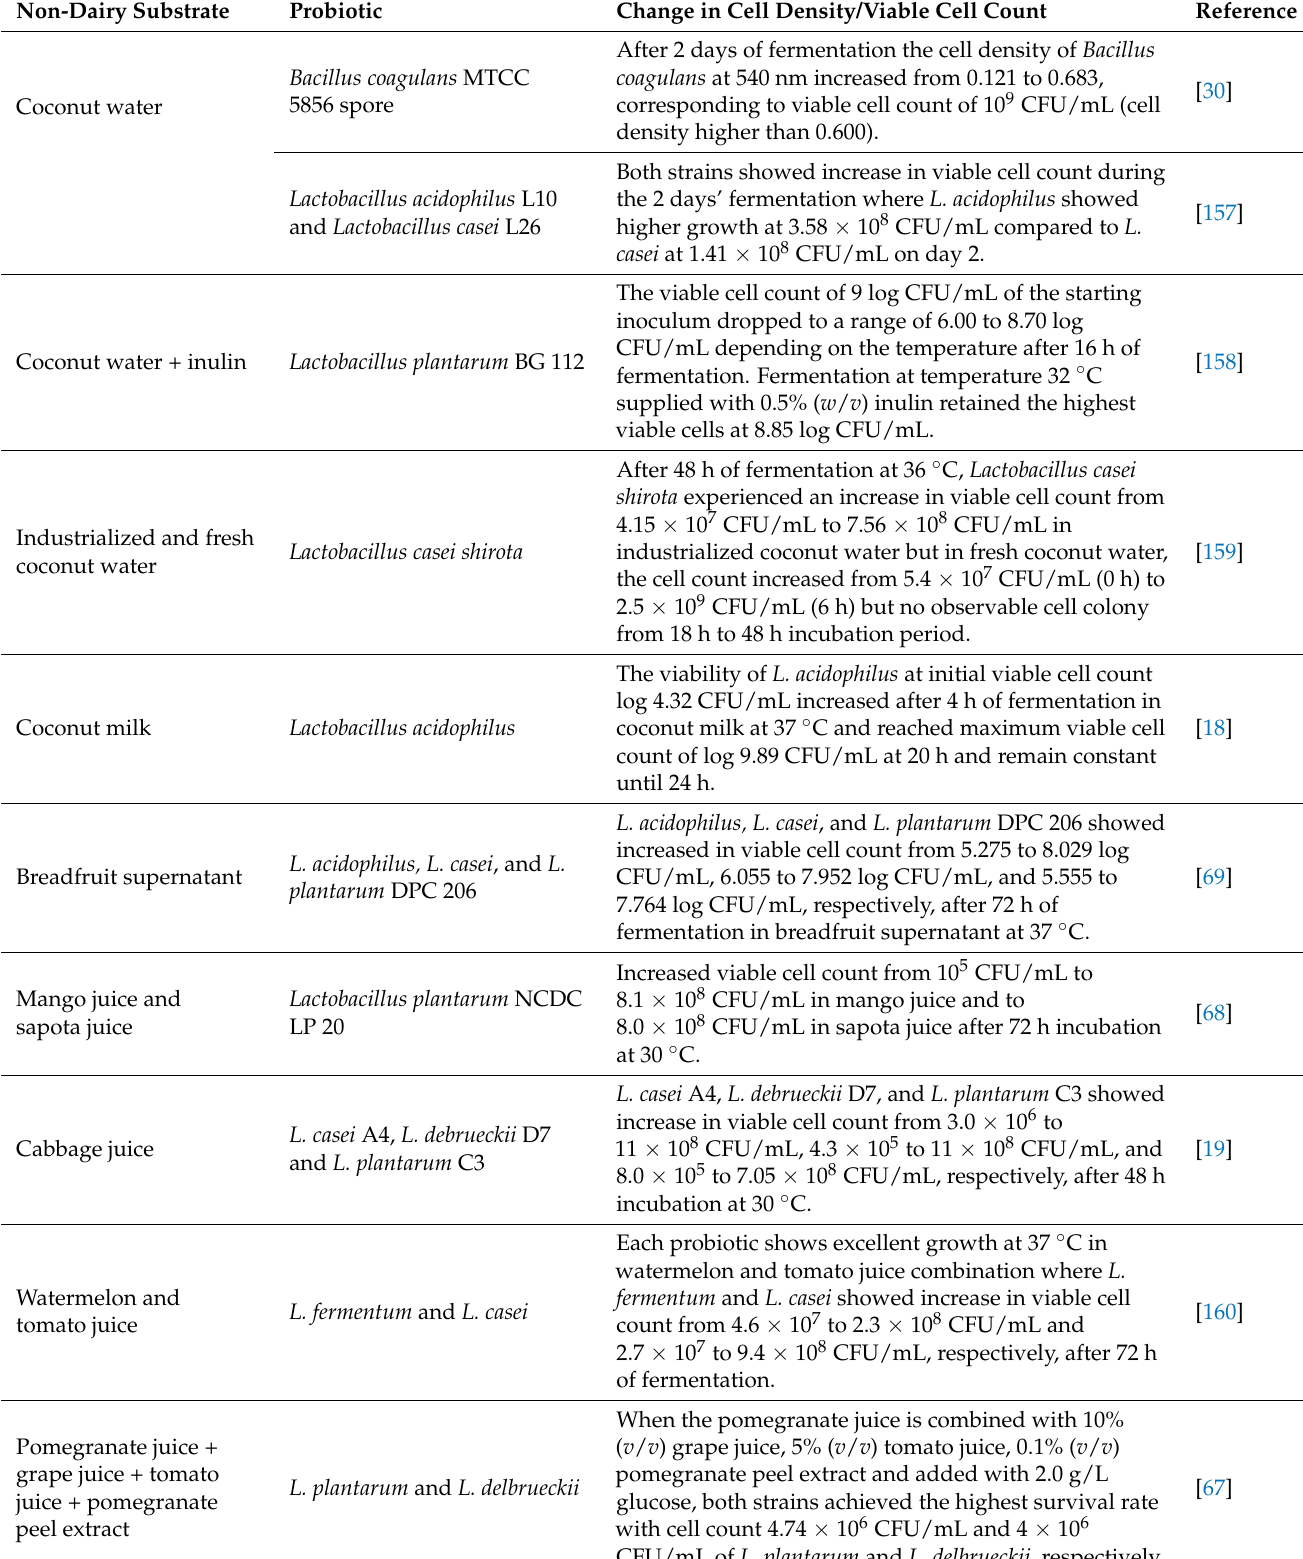
Table 4. Change in viable cell count of probiotics grown on fruits and vegetable